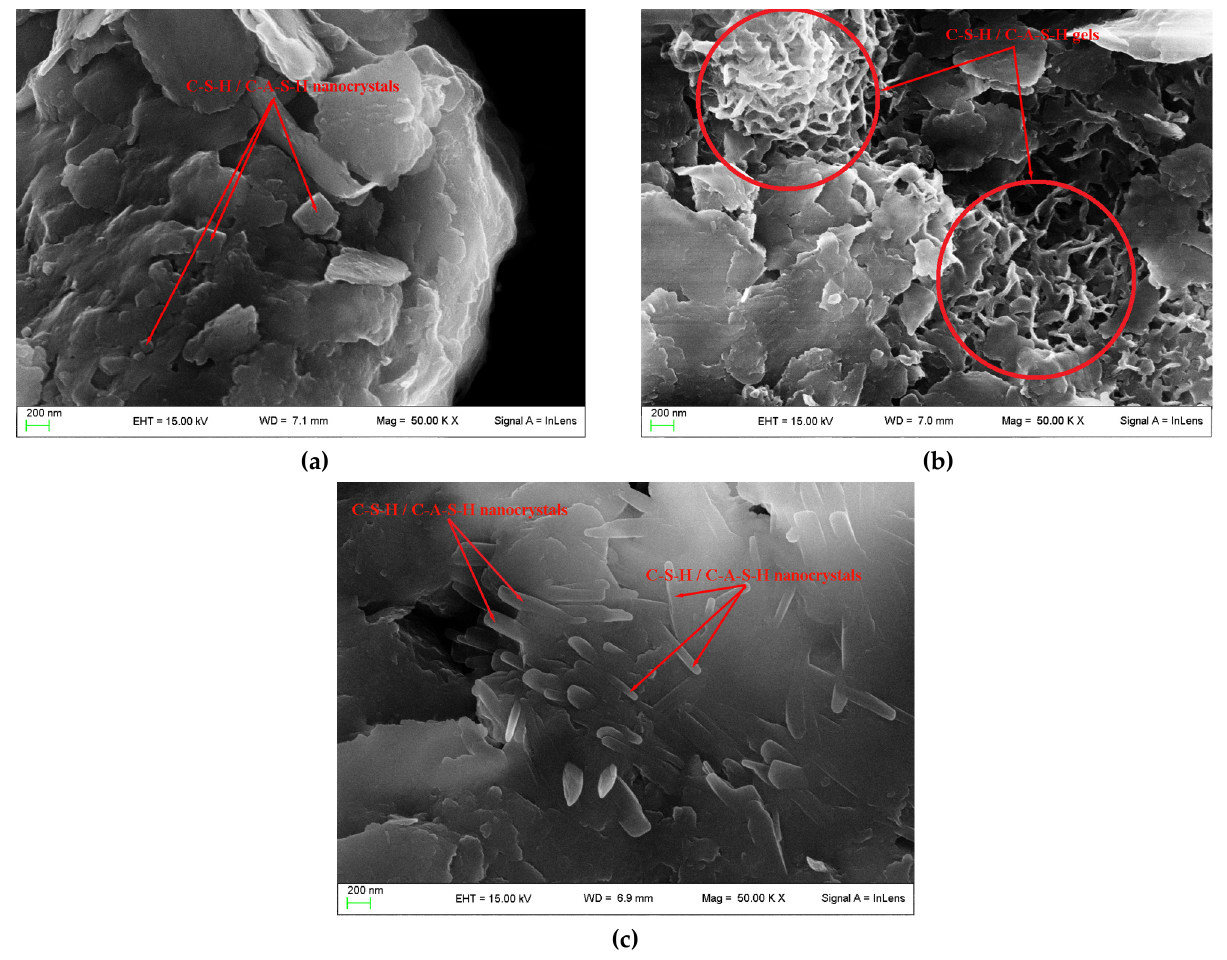
Figure 9. Fe-SEM photos of treated PR/PeA/GEOS ( a ), PR/OlA/GEOS ( b ), and PR/GrA/GEOS ( c ) after 60 days. The images show C-S-H/C-A-S-H nanocrystals ( a – c ) and honeycomb textures C-S-H/C-A-S-H gels ( b